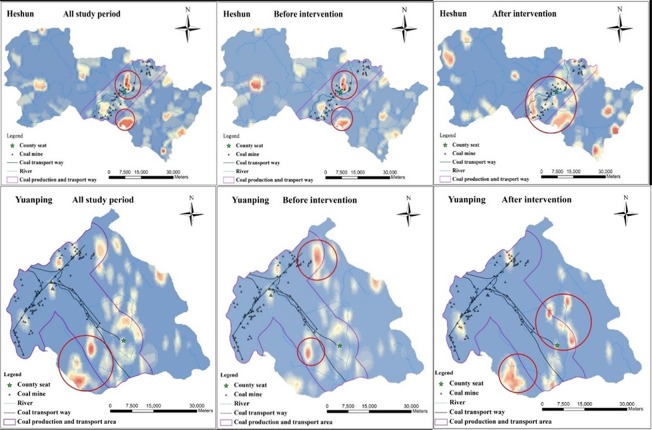
Cluster areas of NTDs in Heshun County and Yuanping County.